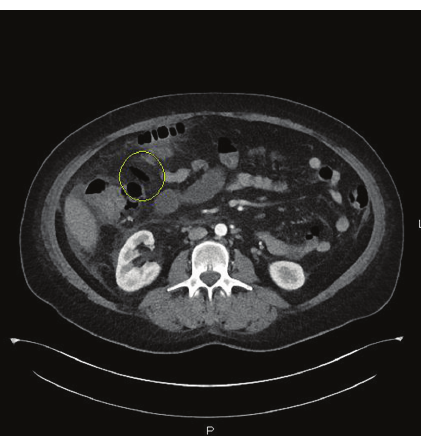
Figure 1: Contrast-enhanced CT abdomen showing wall thickening in the ascending colon with pericolonic stranding pattern and adjacent free air (circle) suggestive of colon perforation.